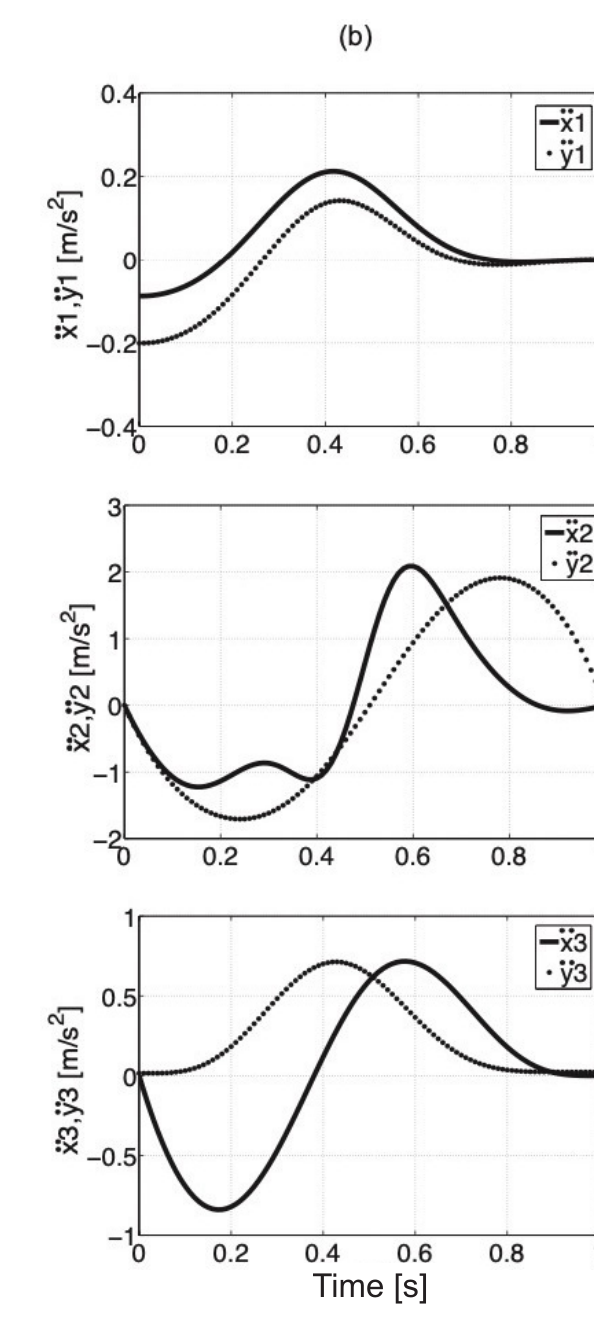
Figure 4. Acceleration values of the mass center of the trunk, thigh, and shank on x - and y -axis ( a ), acceleration values of the mass center of actuators 1, 2, 3 ( b